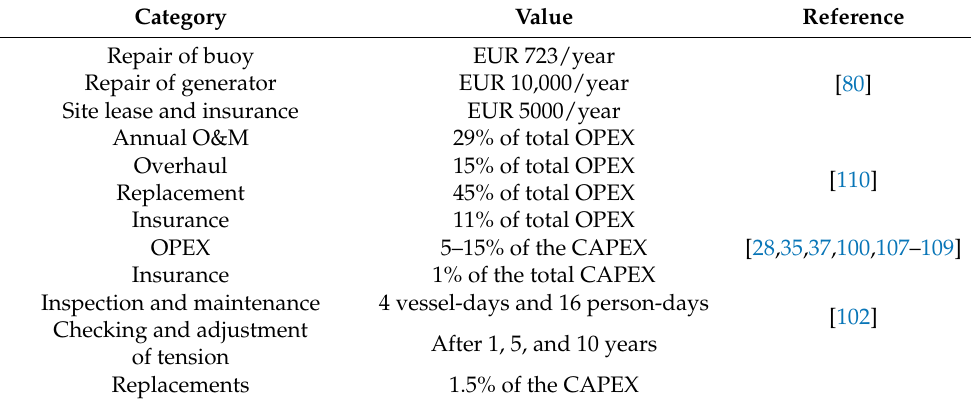
Figure 10. CAPEX per unit of case study simulated in the sea area of USA (Adapted with permission from Ref. [30]. 2018, Chang, G., et al.). Table 4. Summary of the